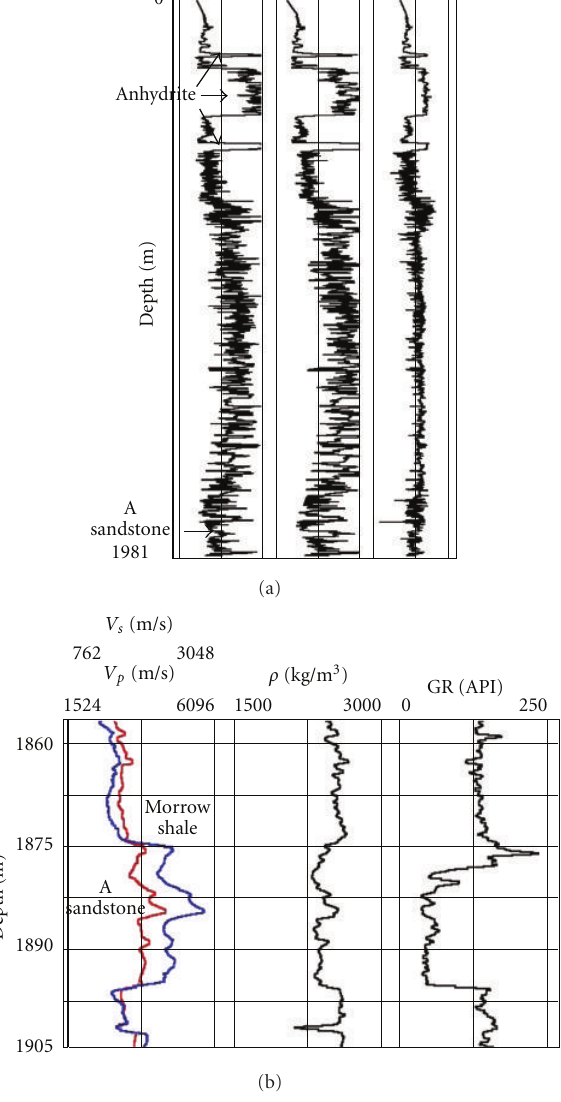
Figure 3: Well logs used for modeling show Morrow A sandstone at 1875m and shallow anhydrite layers. Close-up of the Morrow interval (b) shows the strong S-wave velocity (blue curve) contrast as compared to P-wave velocity (red curve) contrast between Morrow shale and A